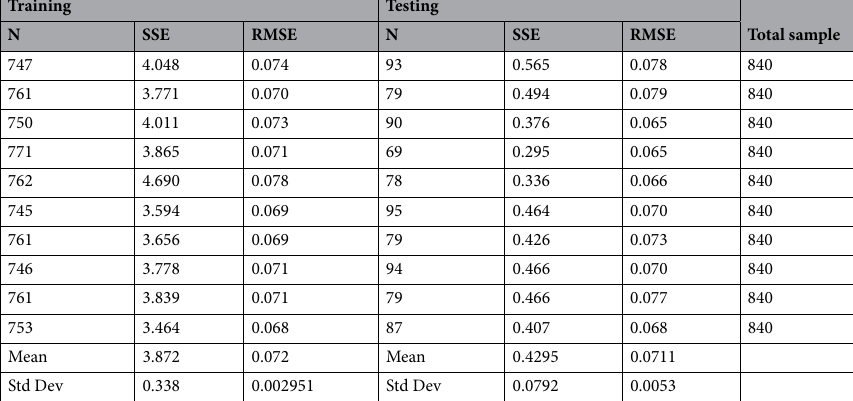
Table 8. RMSE values. 1. R 2 = 1-RMSE/S 2 , where S 2 is the variance of the test data’s desired output. 2. N = number of samples, RMSE = root mean square of errors. 3. Perceived Performance; Perceived Functional Value; Perceived Value; Perceived Satisfaction; Hedonic Motivation; Curiosity; Social Influence; Environmental Awareness; Facilitating Condition, Cost Value served as the input neurons. 4. Behavioural intention served as the output neuron.